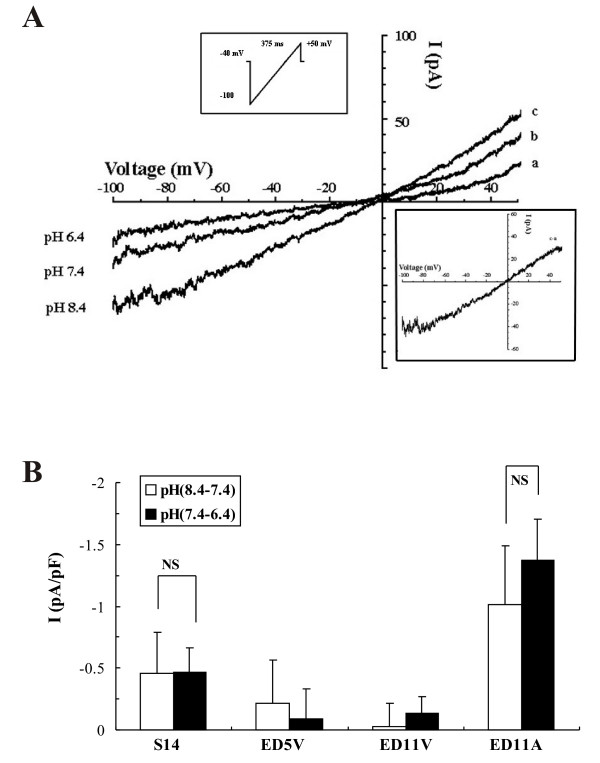
Patch clamp studies of acid-sensitive K+ currents (TASK currents) at different embryonic ages. The background K+ currents were activated with a 375 ms depolarizing ramp from -100 mV to +50 mV from a holding potential of -40 mV in an elevated [K+]o (125 mM). A: representative recordings of background K+ currents in ED11 atrial myocytes and their pH sensitivity. The pH is indicated next to each trace. B: The difference currents between pH 8.4 and pH 7.4 (blank column) and between pH 7.4 and pH 6.4(filled column) at -80 mV at different developmental ages as indicated under each column. The data were averaged from n = 9 (S14), 3 (ED5 ventricle), 4 (ED11V), and 6 (ED11A) cells.